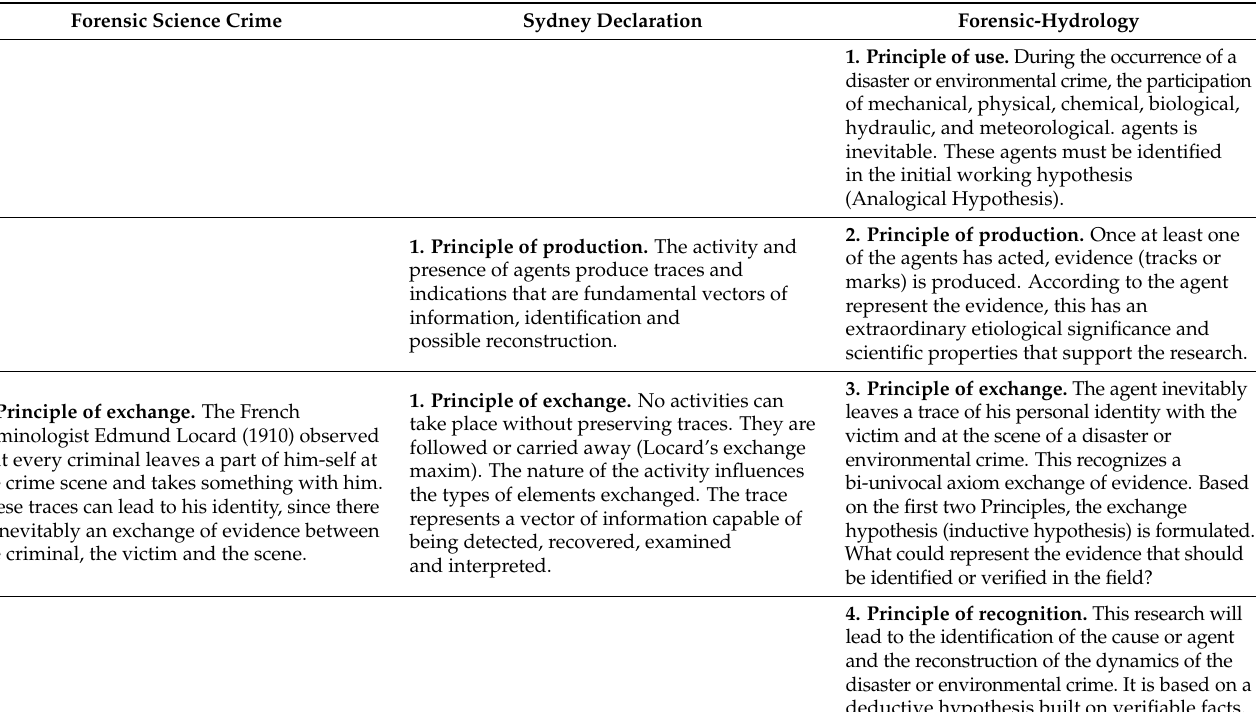
Table 1. Comparison of the Principles of Criminalistic Investigation adapted from